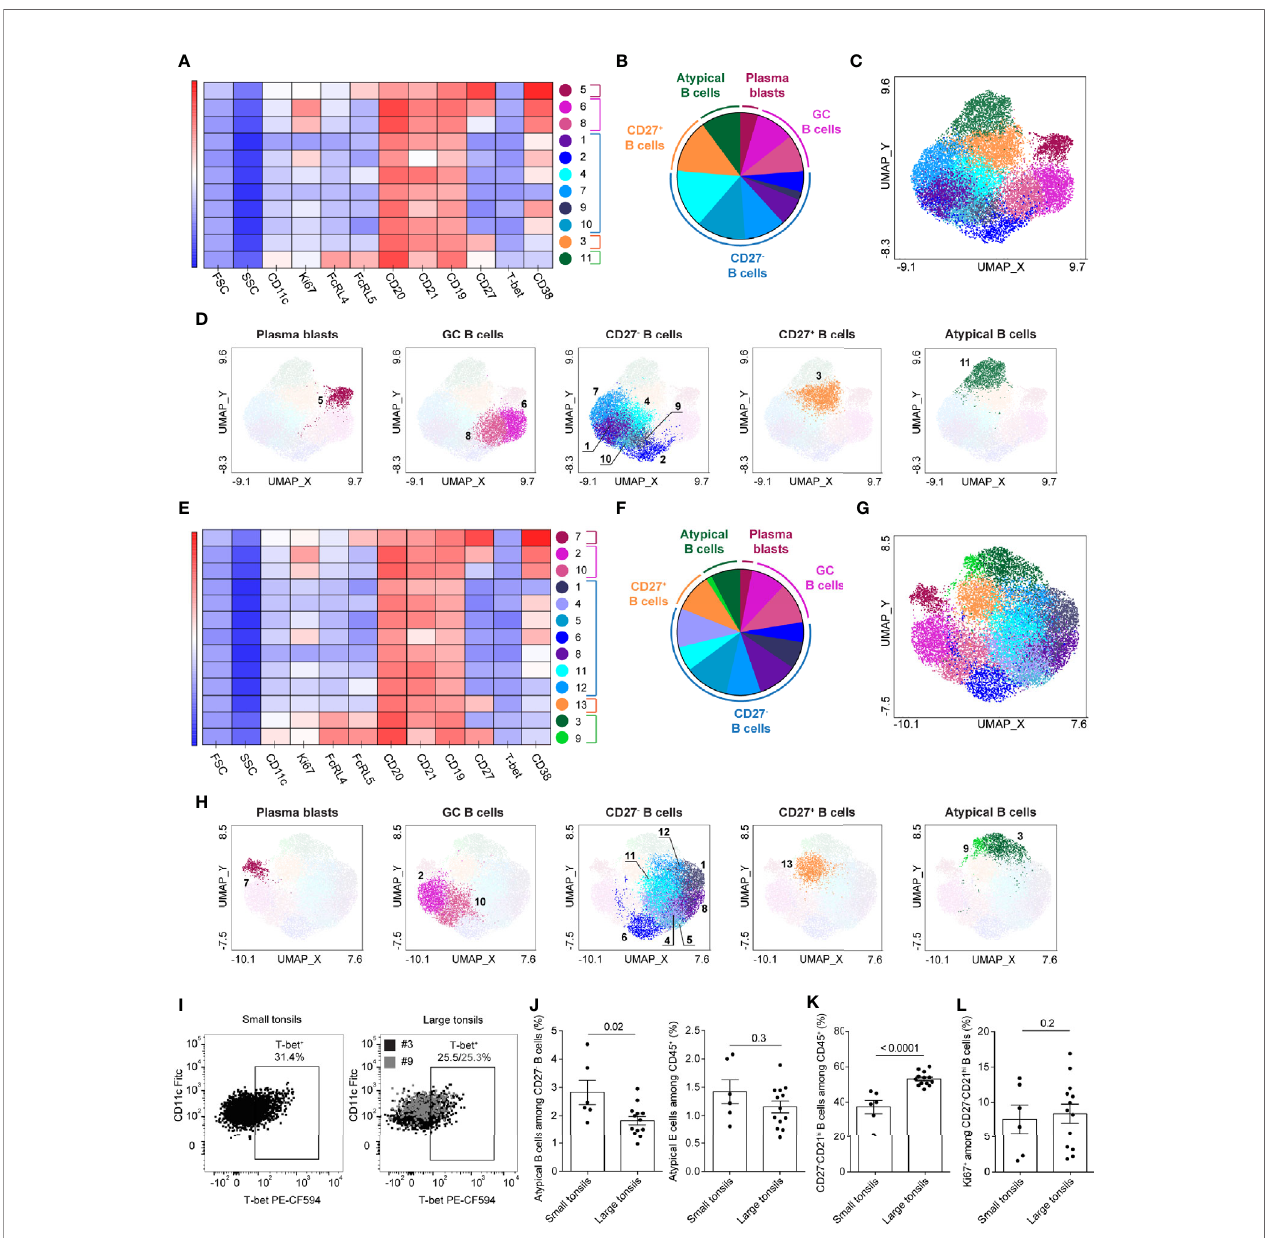
FIGURE 5 | Atypical memory B cells in tonsils of pediatric patients with OSA. (A – H) B-cell clusters in small (A – D) and large (E – H) tonsils from patients with OSA, identi fi ed by PhenoGraph in the concatenated fi les. A different panel of markers to those in Figure 4 was applied to allow a better resolution of atypical B-cell populations. (A, E) Heatmap of marker expression intensity scaled individually for each marker. (B, F) Diagram showing proportions of PhenoGraph clusters and combined functional groups. (C, D, G, H) PhenoGraph clusters overlaid on the corresponding UMAP together (C, G) or separated by functional group (D, H) . (I) T-bet and CD11c expression in the atypical memory B-cell clusters identi fi ed by PhenoGraph in small and large tonsils. (J) Frequency of atypical memory B cells among CD19 + CD20 + B cells and total living CD45 + cells. (K) Frequency of CD27 - CD21 hi B cells among total living CD45 + cells. (L) Frequency of Ki67 + cells among CD27 - CD21 hi B cells. (I – L) Bars and error bars indicate mean ± SEM. Statistical signi fi cance was calculated using Mann-Whitney U